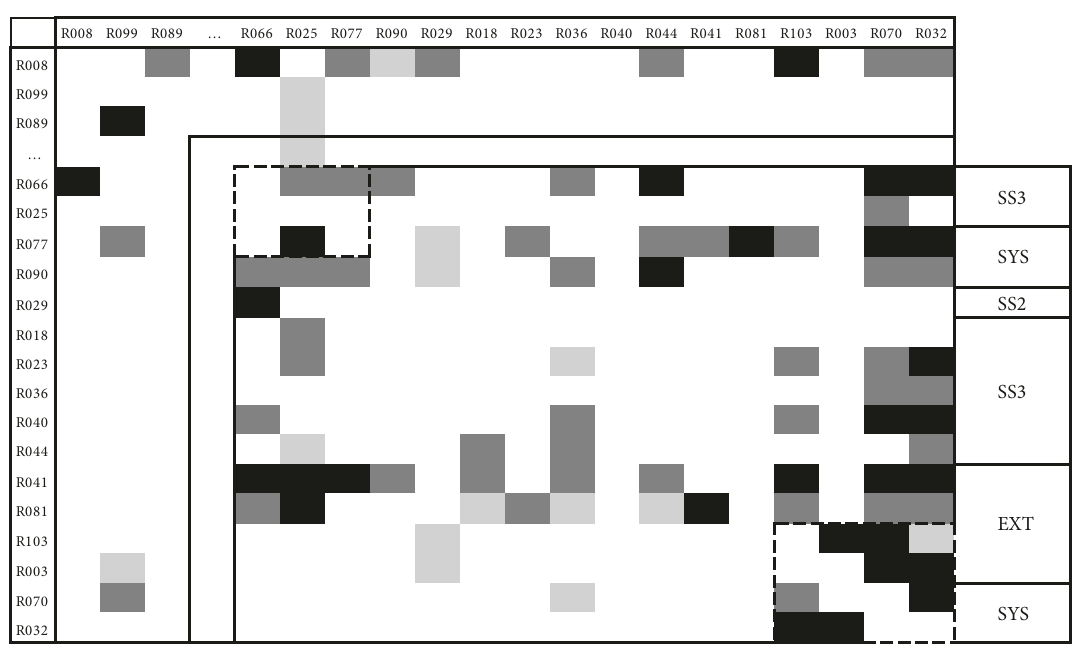
Figure 8: The cluster C 4 intertwined with C 3 (up-left) and C 5